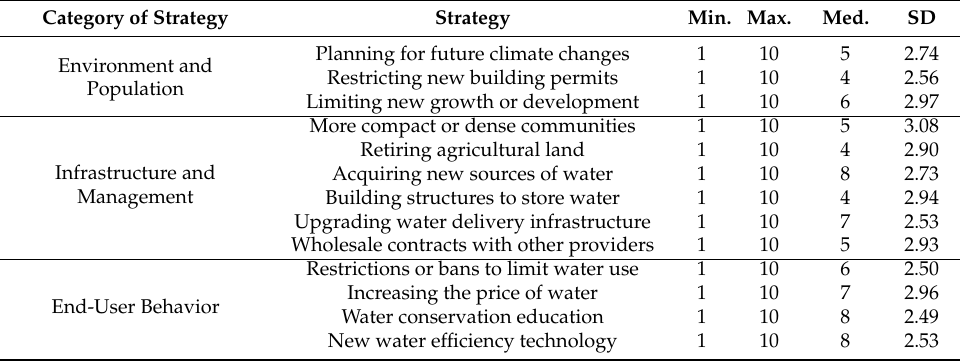
Table 2. Strategies listed for consideration in survey with descriptive statistics (Minimum, Maximum, Median, Standard